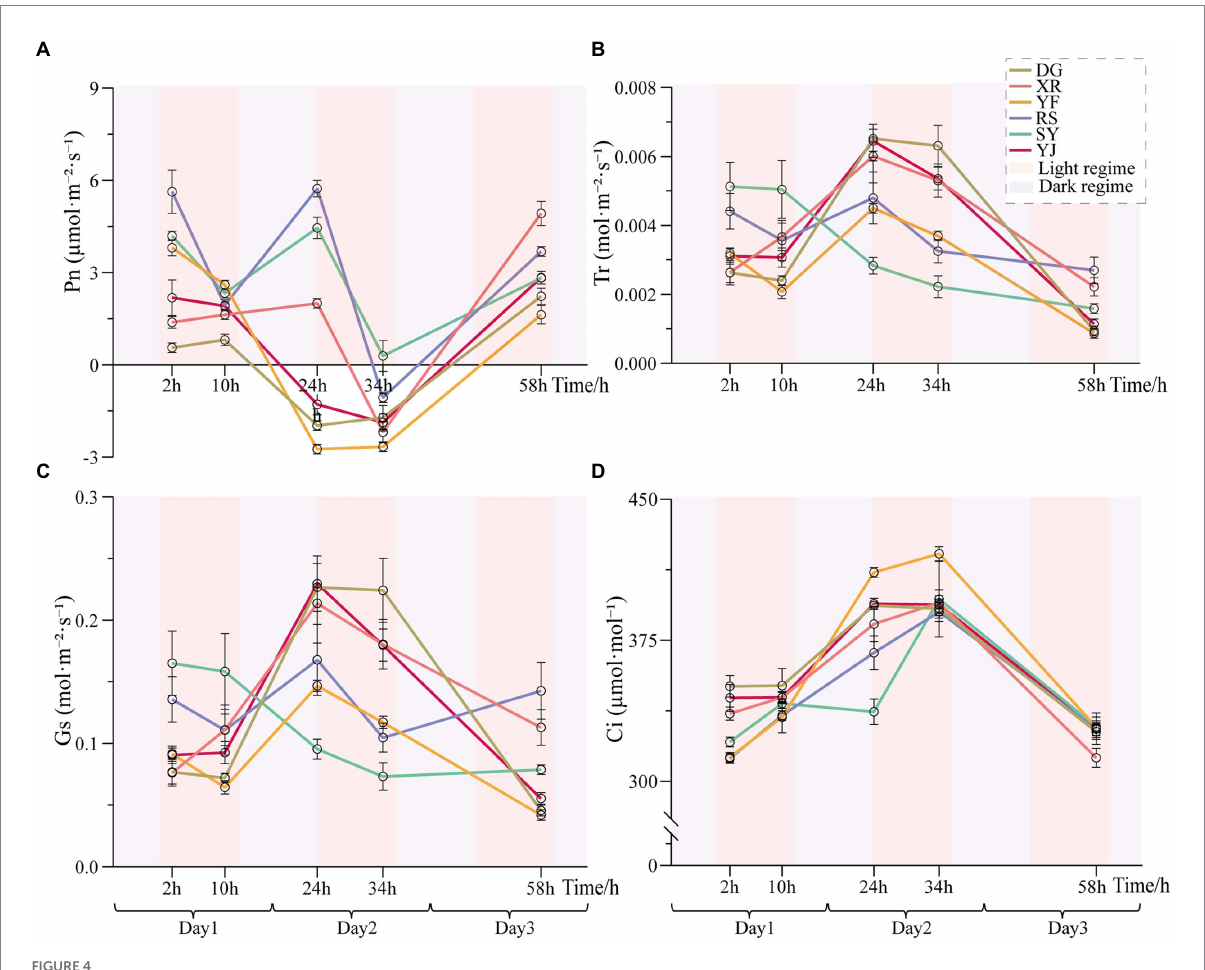
FIGURE 4 Photosynthetic parameters of B. luminifera populations under heat treatments. (A) Net photosynthetic rate ( P n ). (B) Transpiration rate ( T r ). (C) Stomatal conductance ( G s ). (D) Intercellular CO 2 concentration ( C i ). Error bars indicating standard error (SE).